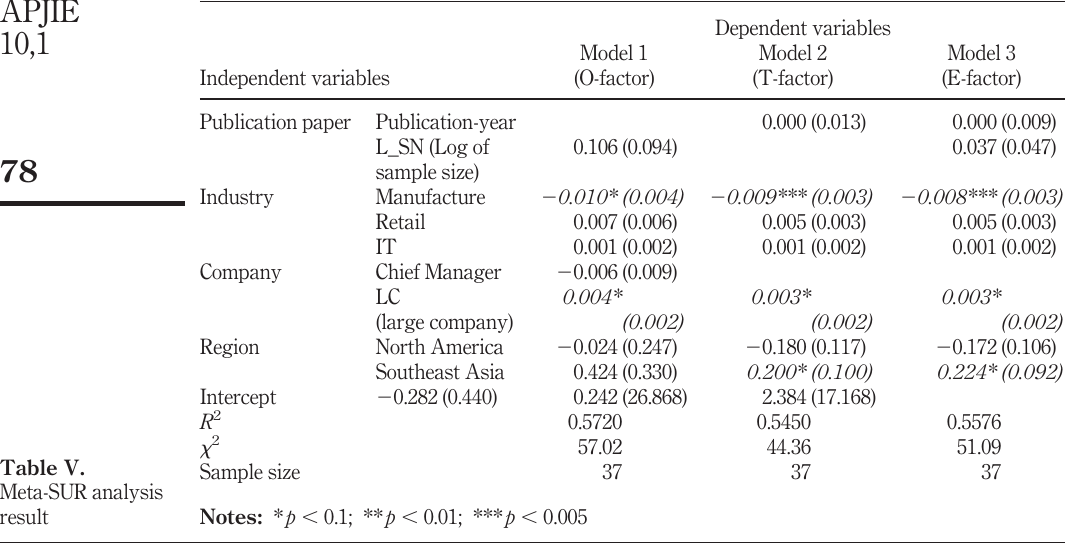
Table V. Meta-SUR analysis